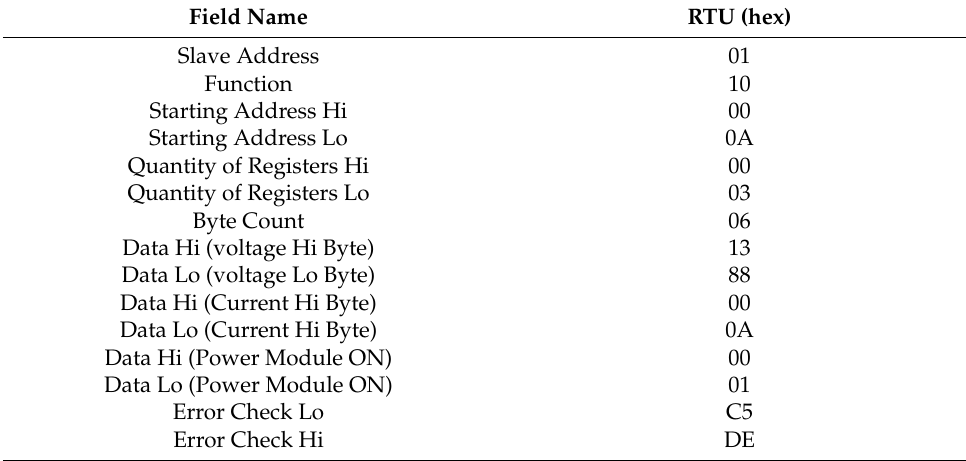
Table A2. Request to write values to